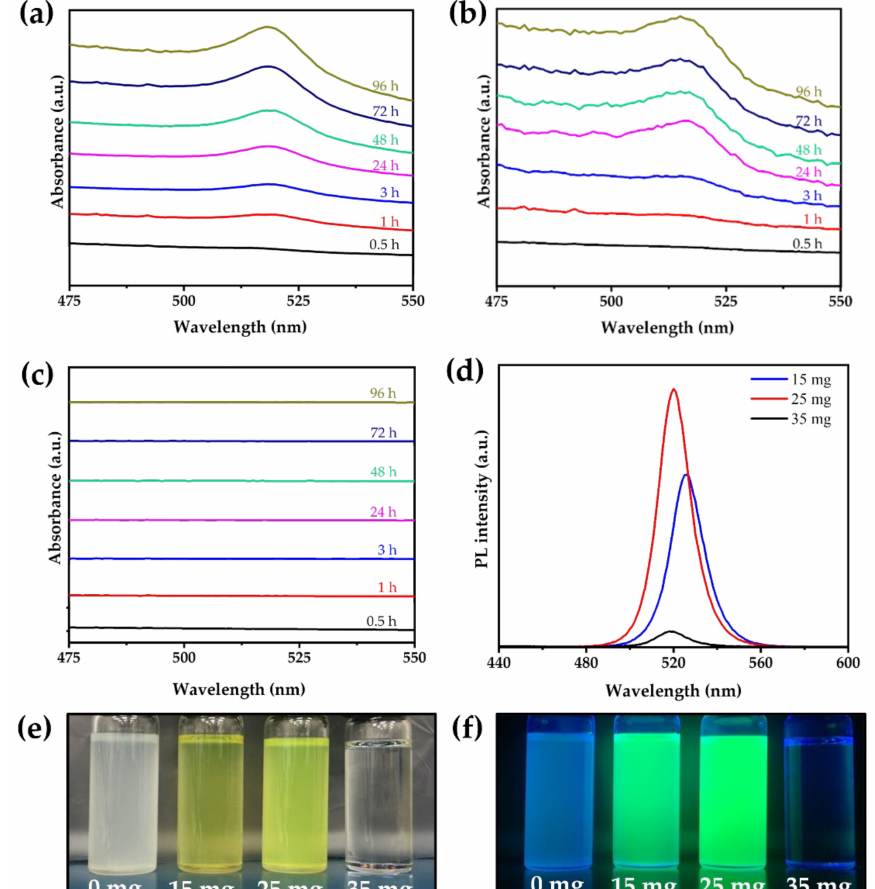
Figure 5. Time-dependent absorption spectra of the CsPbBr 3 MC solutions synthesized using different amounts of PAA: ( a ) 15 mg, ( b ) 25 mg, and ( c ) 35 mg PAA. ( d ) PL spectra of the CsPbBr 3 MC solutions synthesized with different amounts of PAA obtained via the ethanol/water treatment. Photographic images of the CsPbBr 3 MC solutions ( e ) under room light and ( f ) UV